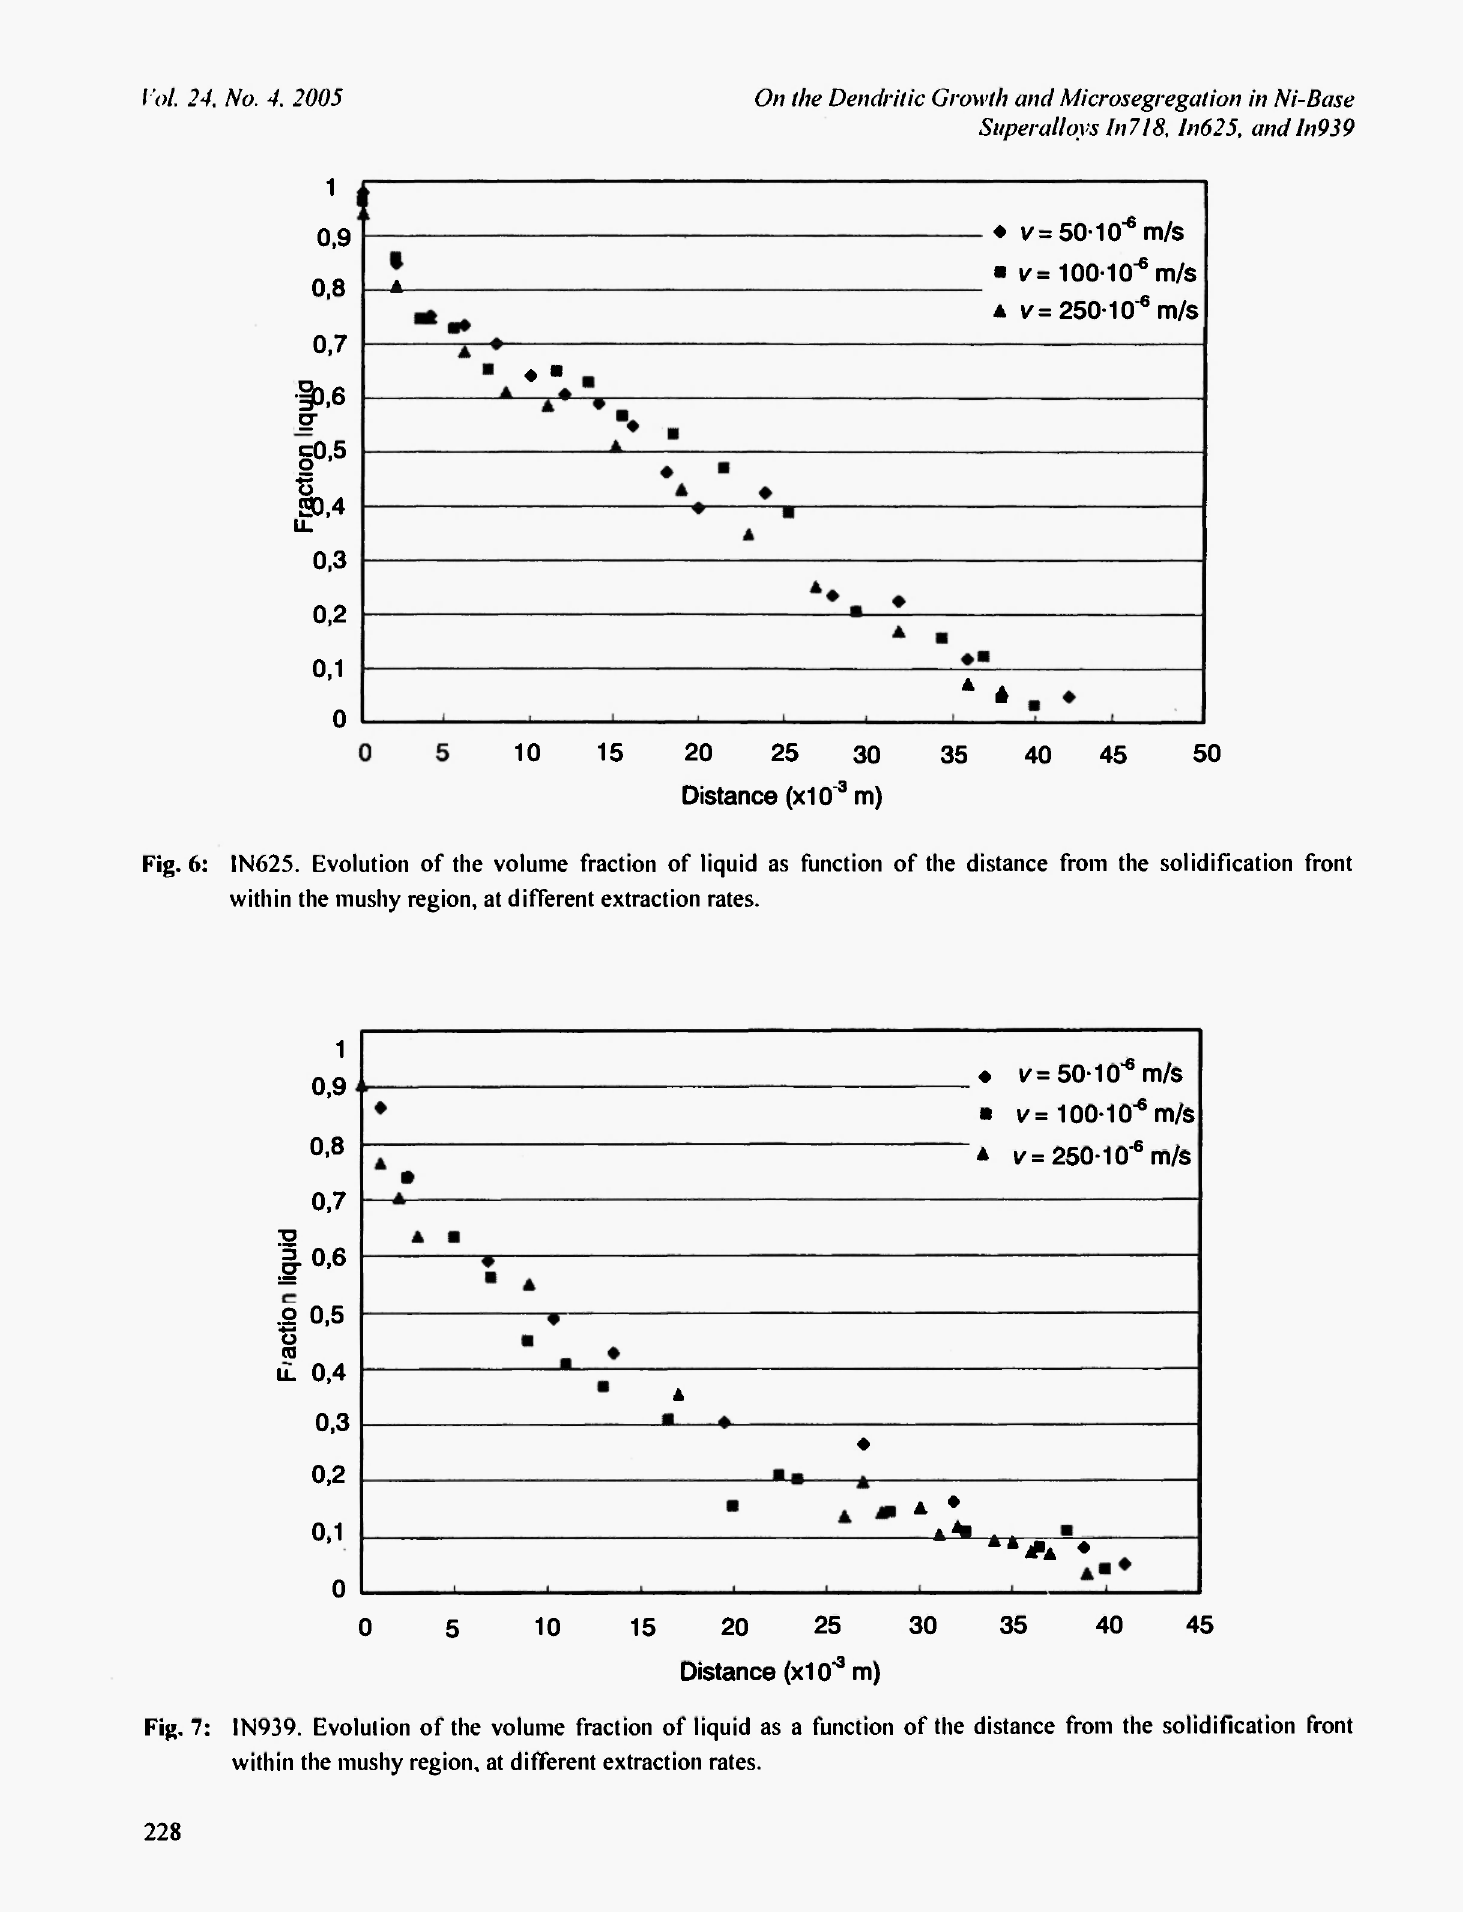
Fig. 6: IN625. Evolution of the volume fraction of liquid as function of the distance from the solidification front within the mushy region, at different extraction rates.